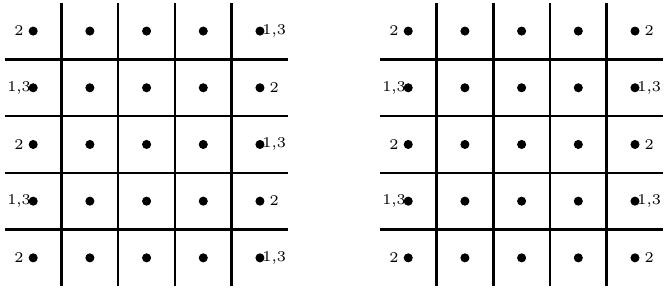
Figure 24 . Left panel: anti-correlated boundary condition A = . Right panel: correlated boundary condition C = .